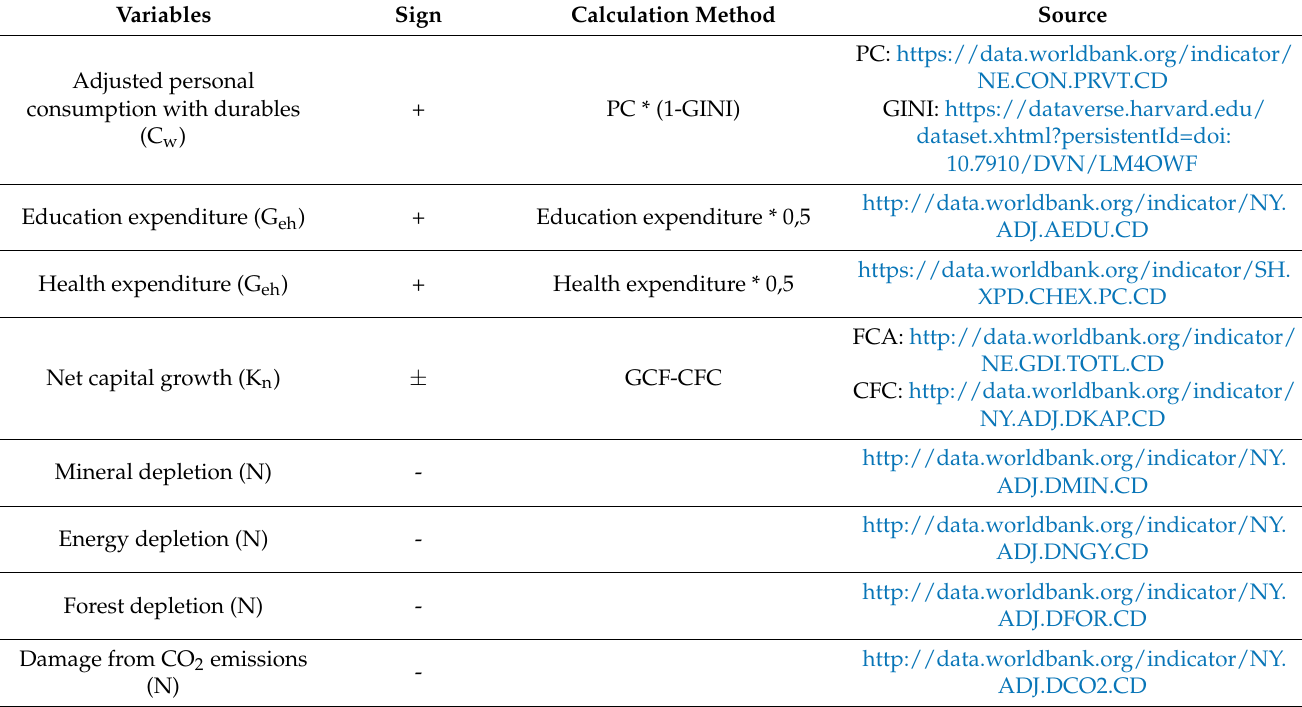
Table 2. Index of Sustainable Economic Welfare (ISEW)